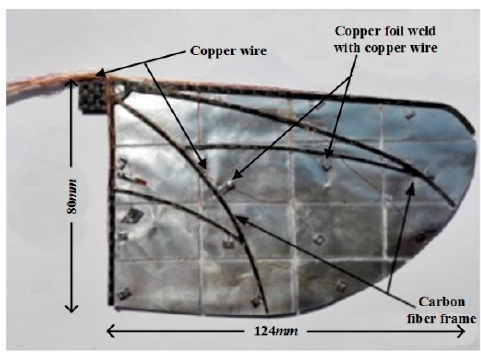
Figure 2. Polyvinylidene fluoride (PVDF) wing composed of carbon fiber frame and PVDF mem-